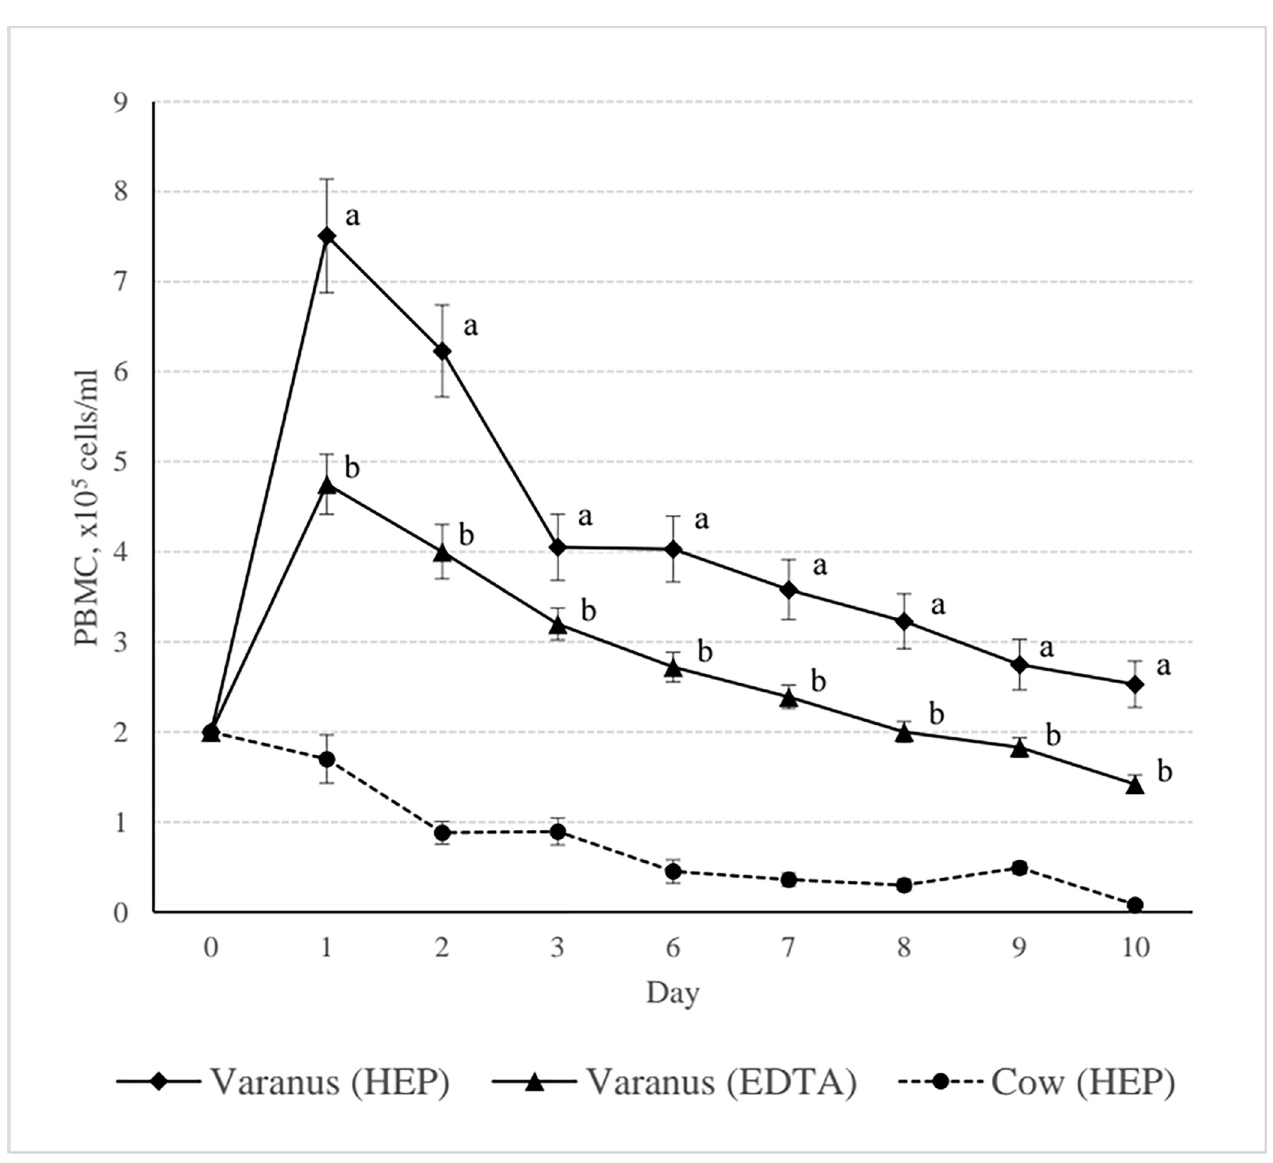
Fig 2. Peripheral blood mononuclear cells (PBMCs) (median ± SE) of heparin blood (HEP) and EDTA blood (EDTA) from Varanus Salvator cultured for 10 days. The PBMCs from cows (n = 10) represent the mammal’s PBMC pattern. a, b Statistical significant of the effect of blood anticoagulants on the Varanus’s PBMCs (Wilcoxon test, P <